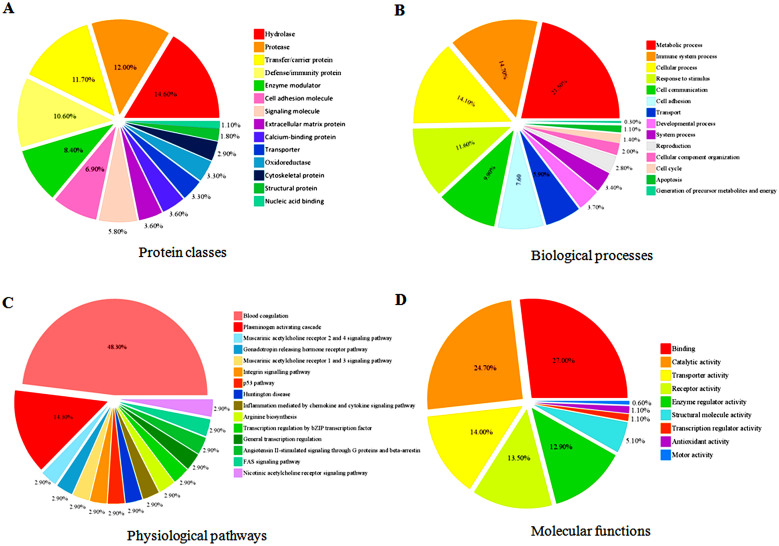
Functional clustering and physiological pathways associated with the differentially expressed proteins identified in meningiomas.Pie charts showing the protein classes (A), protein classes (B), biological process (C), and physiological pathways (D) molecular functions.